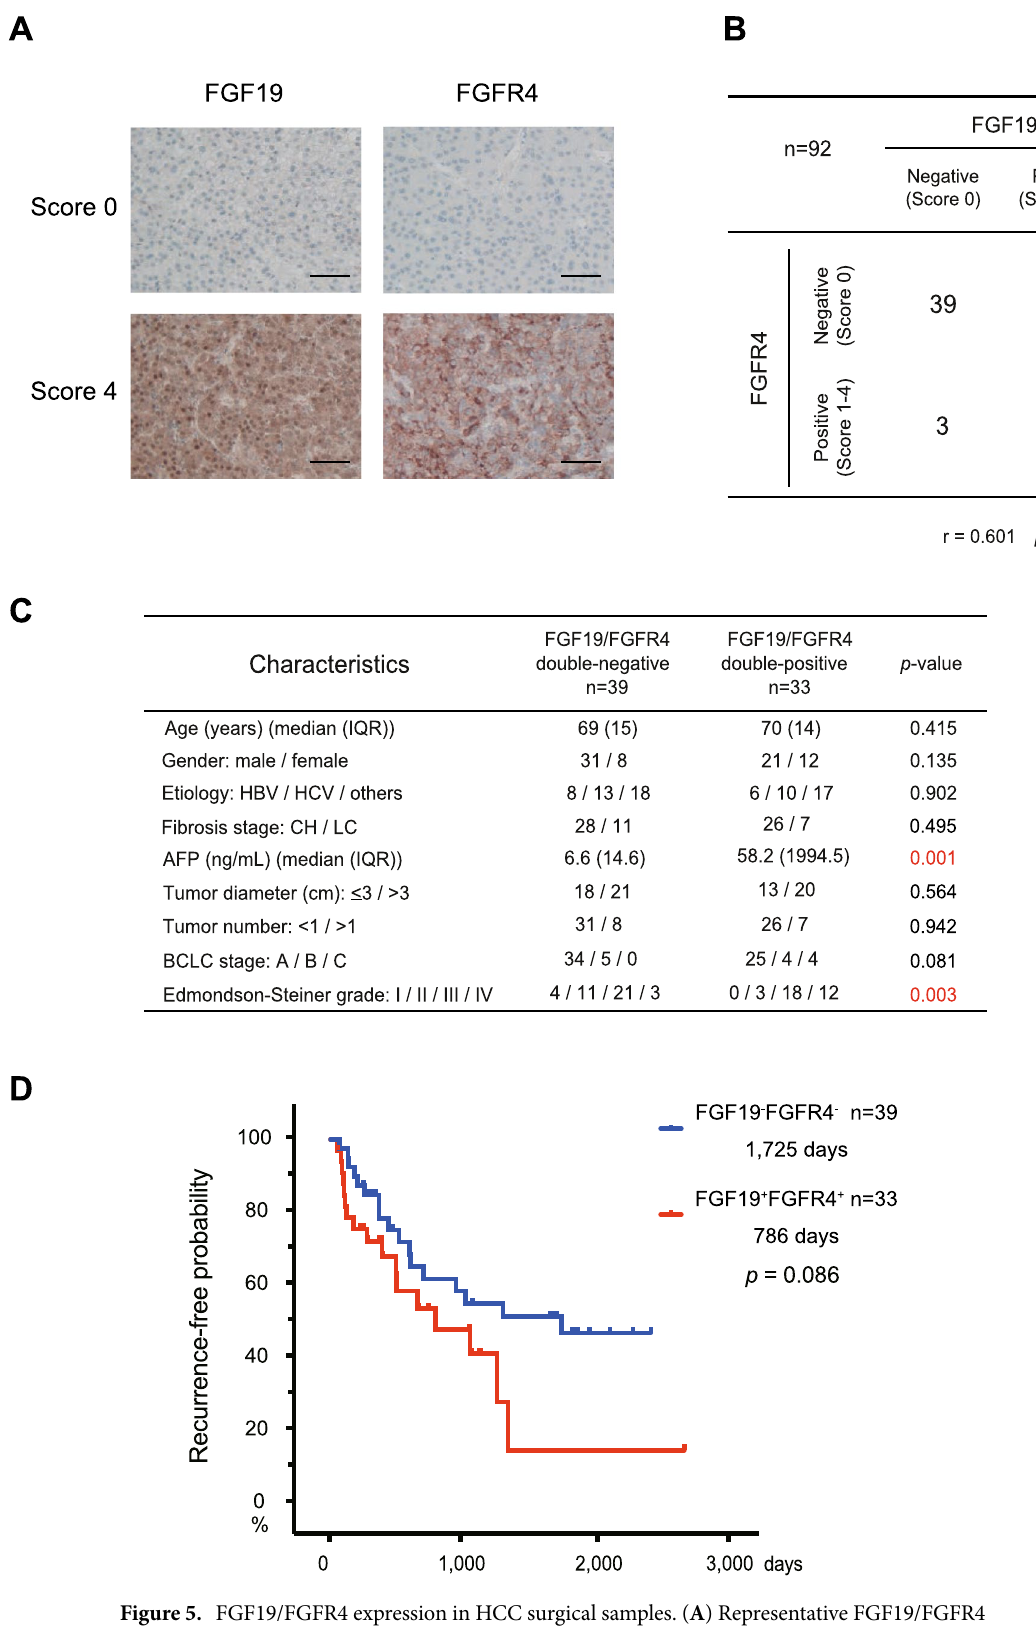
Figure 5. FGF19/FGFR4 expression in HCC surgical samples. ( A ) Representative FGF19/FGFR4 immunohistochemical staining of primary HCC tissues (score 0 or 4). Scale bar = 100 μm. ( B ) Correlation between FGF19 and FGFR4 expression. ( C ) Clinicopathological features of FGF19 + FGFR4 + and FGF19 − FGFR4 − HCC. ( D ) Cumulative RFS rate based on the FGF19/FGFR4 expression